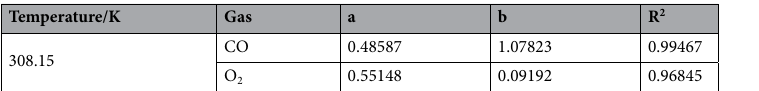
Table 5. Langmuir fitting parameters of competitive CO/O 2 adsorption at 308.15 K.